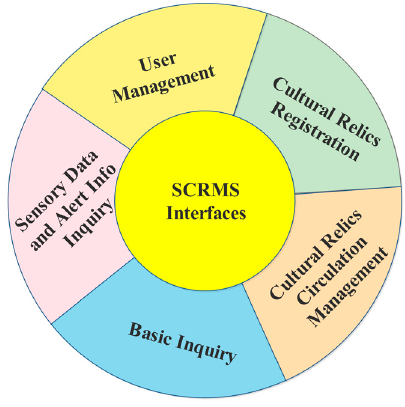
Figure 4. Five categories of interfaces.